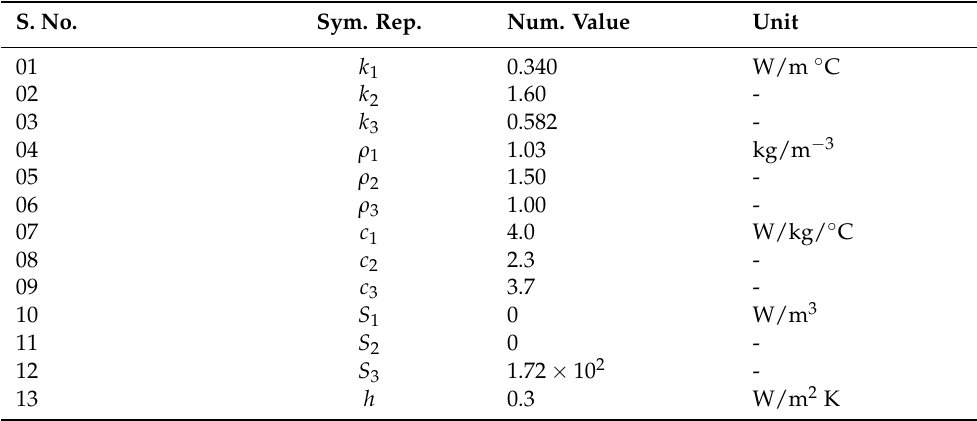
Table 2. Numerical values of the parameters for the